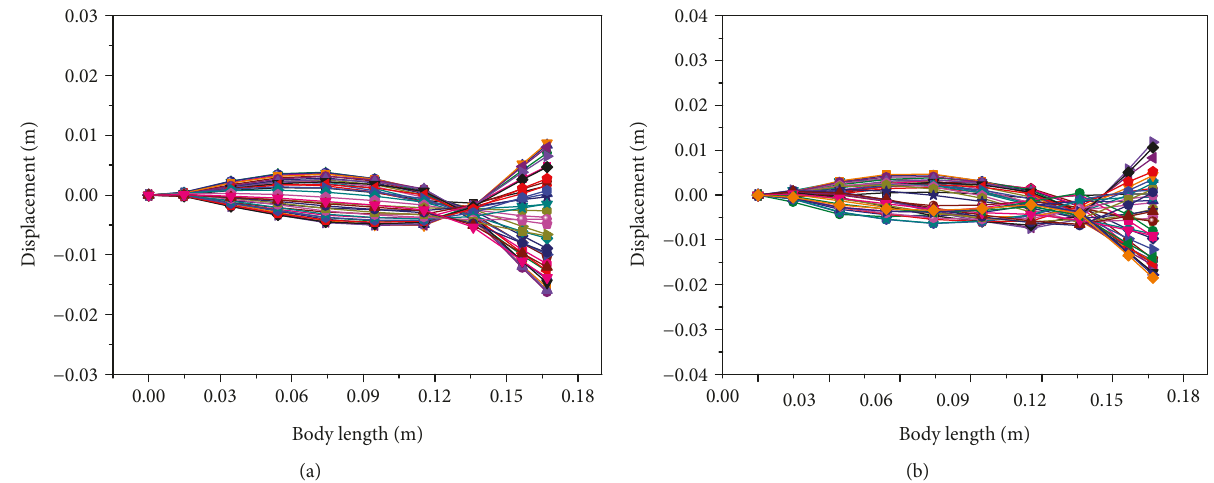
Figure 14: Propulsion modes of soft robotic fi sh in one cycle at 3Hz in the motion of turning right. (a) Results in sine waveform. (b) Results in square waveform.